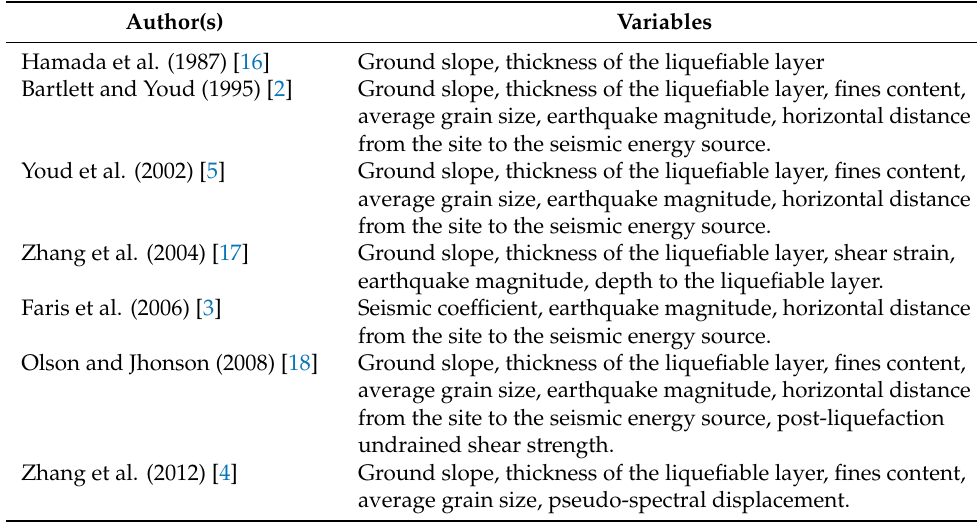
Table 1. Lateral spreading prediction